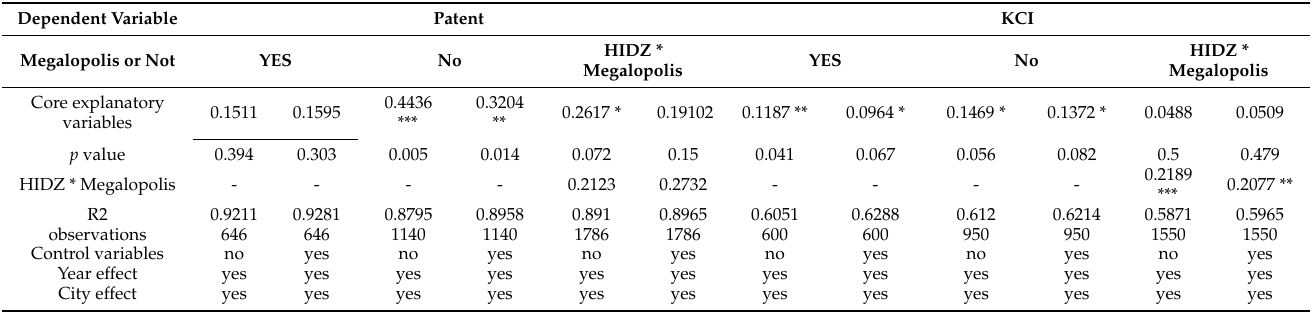
Table 6. HIDZ’s effects given whether it belongs to the four major urban